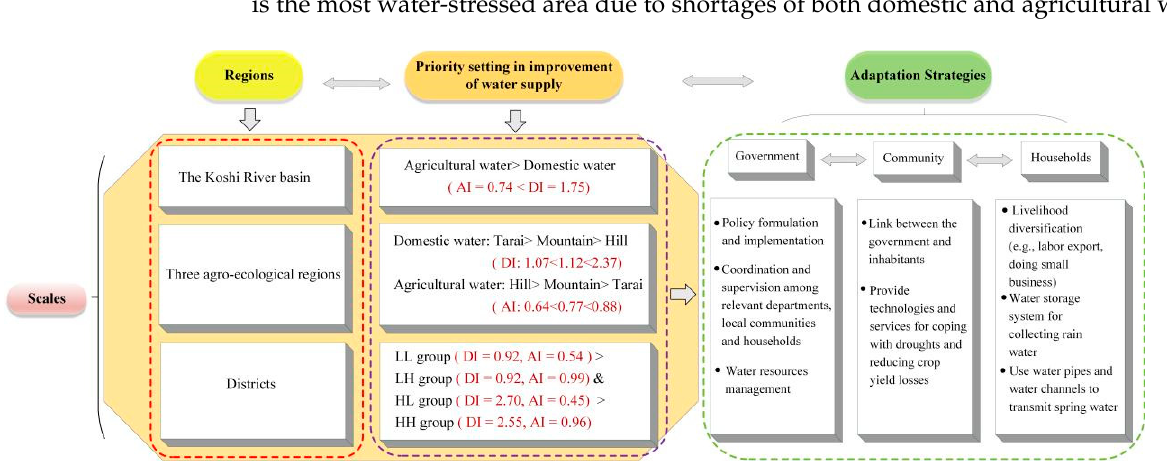
Figure 7. The priority setting in the improvement of water supply systems and adaptation strategies for mitigating water stress.